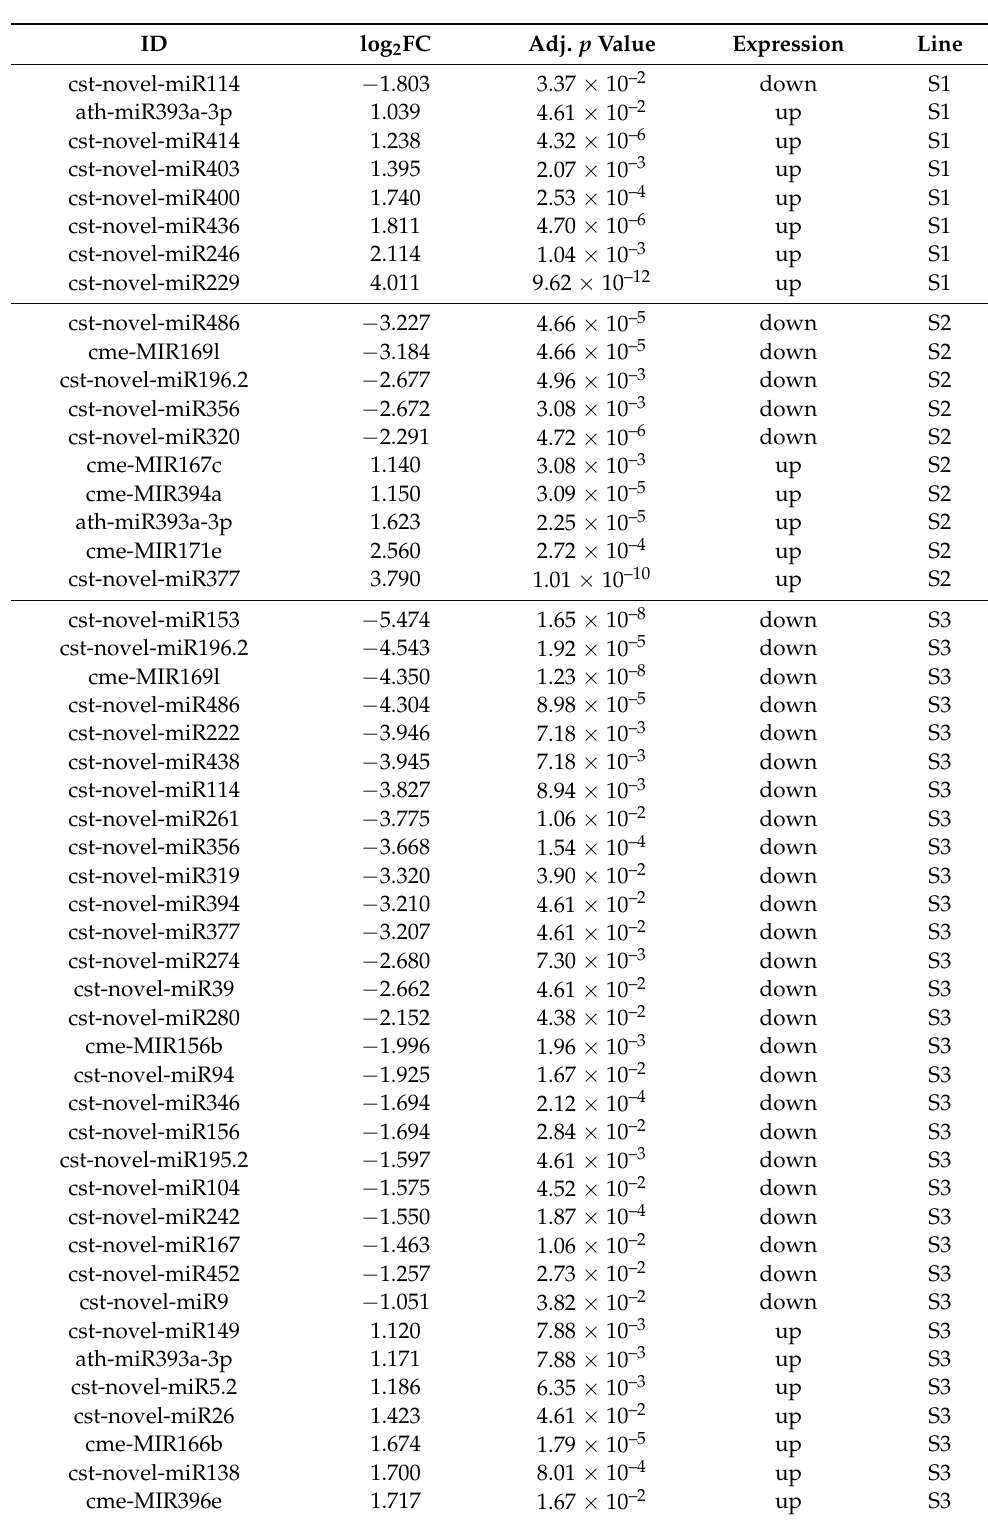
Table 2. Differentially expressed miRNAs in three somaclonal lines (S1, S2 and S3) in comparison to B10